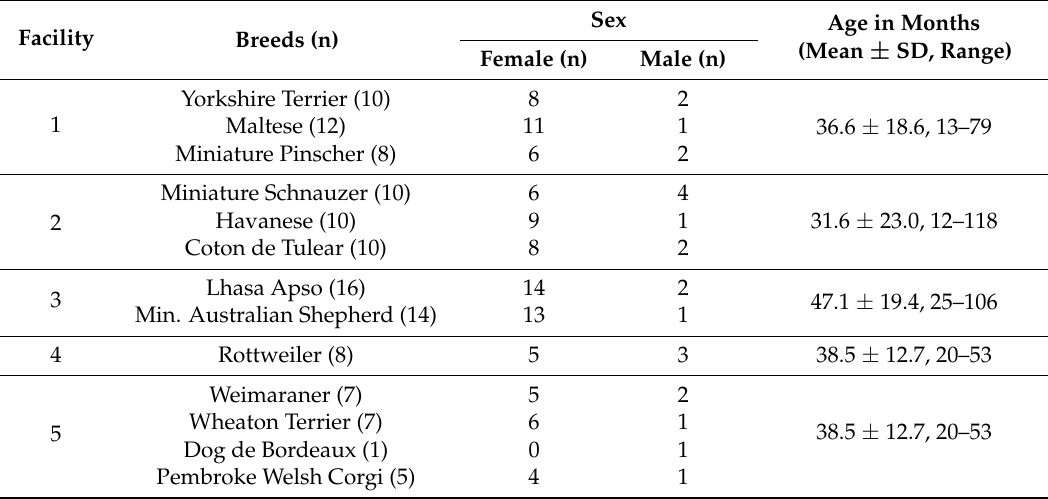
Table 1. Dog information. Demographics of the population